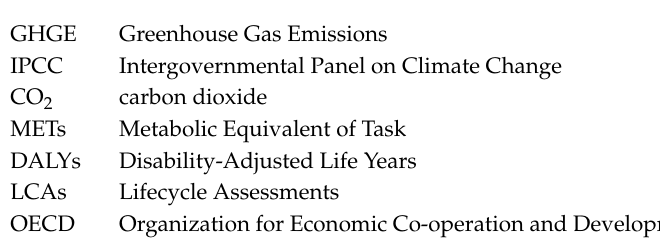
Table S1: Detailed summary of reviewed articles and their measured health and GHGE outcomes; Table S2: Types of dietary changes examined in reviewed articles; Table S3: A summary of health outcomes evaluated in each article; Table S4: A summary of the modeling tools used to estimate physical activity impact on health in reviewed